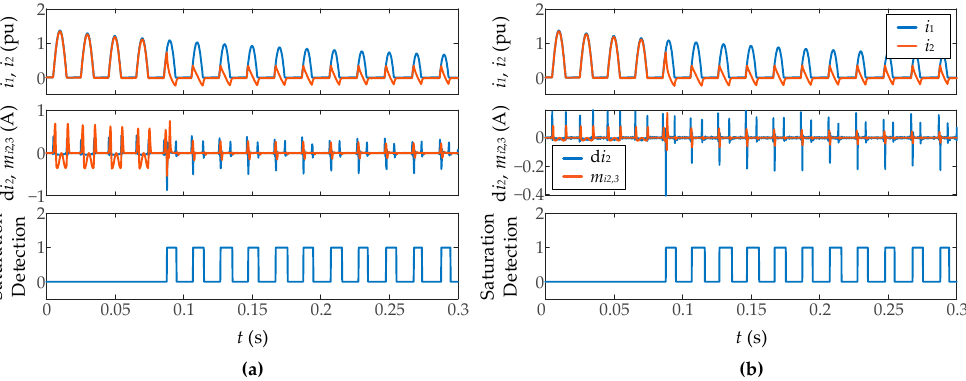
Figure 17. Performance of smart sensor during inrush current measurement in real time.